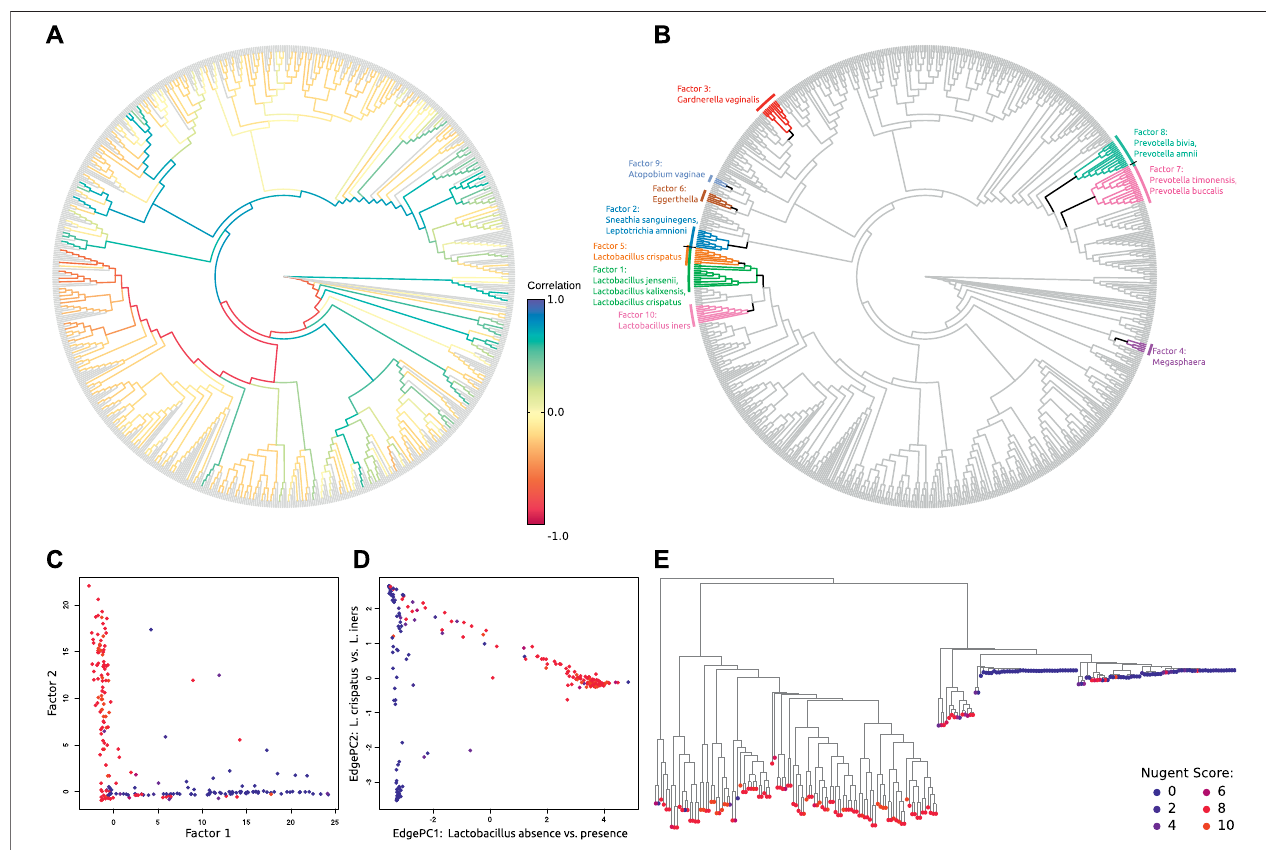
FIGURE 5 | Analyses of phylogenetic placement data. Here, we show several analysis techniques for placement data, which relate multiple samples to each other (e.g., from different locations or points in time) that have been placed on the same underlying reference tree. The example dataset contains 220 vaginal samples of humanpatientswithandwithoutBacterialVaginosis(BV),aconditioncausedbyanabnormalvaginalmicrobiome(Srinivasanetal.,2012),placedonabacterialtree.The “ Nugent ” score is an external clinical indicator of the disease (Nugent et al., 1991), which is shown in (C – E) as blue (healthy, low score) vs. red colors (severe disease, high score). In healthy patients, two types of Lactobacilli dominate the microbiome, while in diseased patients, a diverse mixture of other bacteria take over. All fi gures are adapted from (Czech and Stamatakis, 2019), for details see (Srinivasan et al., 2012; Matsen and Evans, 2013; Czech and Stamatakis, 2019; Czech, 2020). (A) Edge Correlation between read abundances in clades of the reference tree (measured via the imbalance transformation) and the per-sample Nugent score. This visualization method identi fi es taxa whose abundances exhibit a relationship with environmental factors. Here, the red path towards the left identi fi es the Lactobacillus clade, that exhibits a strong anti-correlation with the Nugent score (healthy patients with a low score have high abundances in this clade), while blue and green paths show a multitude of clades that correlate with the score (diseased patients with a high score and high abundances in these diverse clades). (B) Placement-Factorization discretelyidenti fi estheseclades bysplittingupthetreeintoanumberof “ factors ” :Blackedges(withcolorizedcladesbelowthem) indicate the fi rsttenfactors (groupsof taxa, some of them nested) whose differential placementabundances between samples exhibit a strong relationship with the Nugent score. That is, afactor is aclade in which abundances co-vary with metadata (e.g., the Nugent score). Here, these factors are again the Lactobacillus clade and a multitude of other clades that are also highlighted in (A) by colored paths. (C) Placement-Factorization can also ordinate samples, by plotting the balances (i.e., the abundance contrasts) across the edges identi fi edbyfactors.Here,the fi rsttwofactorsof (B) areshown(eachdotrepresentsonesample,coloredbyitsNugentscore),whichsplithealthyanddiseasedpatients. (D) Edge Principal Components Analysis (EdgePCA) is another ordination method, using PCA on the edge imbalances . Here, the fi rst two PC axes are shown, which separate healthy from diseased patients ( Lactobacillus presence vs. absence) on the fi rst axis, and further distinguish the healthy patients based on the two types of Lactobacilli on the second axis. These interpretations of the axes are derived from visualizing the PCA directly on the reference tree, which is another way to show Edge PCA results,see(MatsenandEvans,2013;Czech,2020). (E) SquashClustering isahierarchical clusteringmethod, hereshowingtheclusteringtreeofthesamples(not a phylogeny). Tip nodes (leaves) correspond to samples (individual patients), again colorized by their Nugent score, with samples clustered based on similarity of their placement distribution, and vertical distances showing this similarity, measured as the phylogenetic Kantorovich-Rubinstein (KR) distance between samples. Patients with a similar health status are close to each other, in particular the healthy (blue)